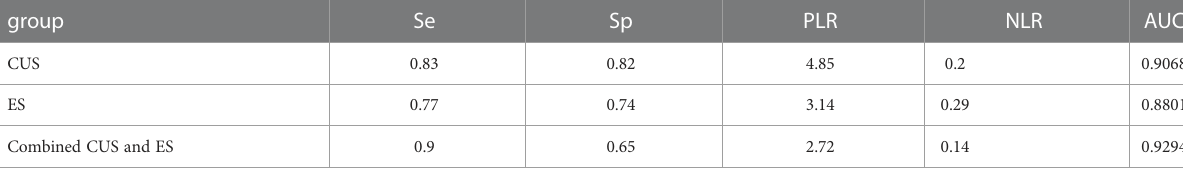
TABLE 3 Summary of pooled estimates of diagnostic for detecting malignant thyroid nodules. group Se Sp CUS